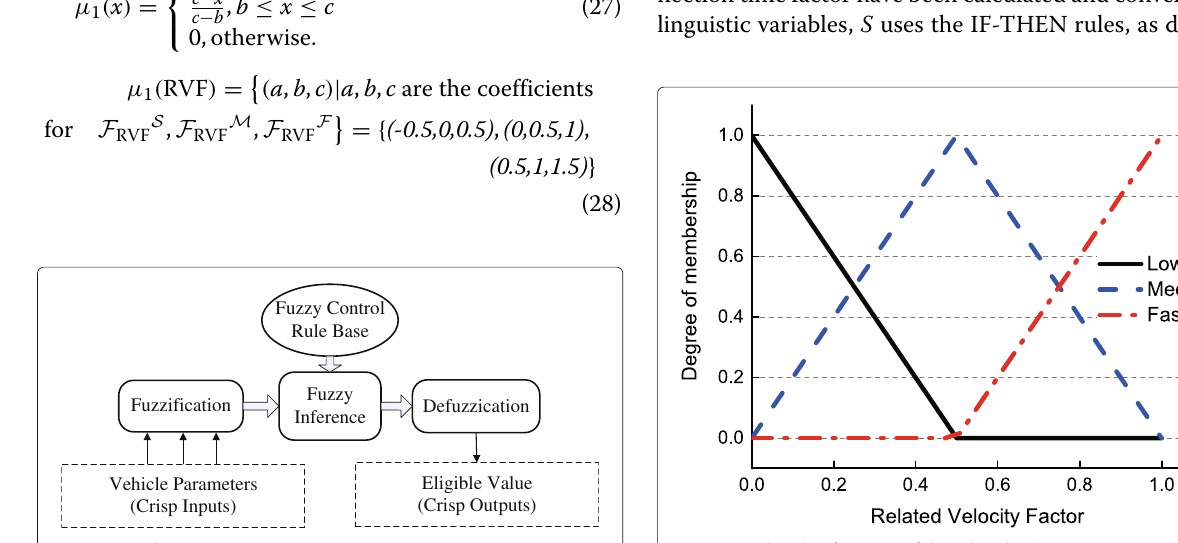
Fig. 7 Fuzzy logic system Fig. 8 Membership function of the related velocity